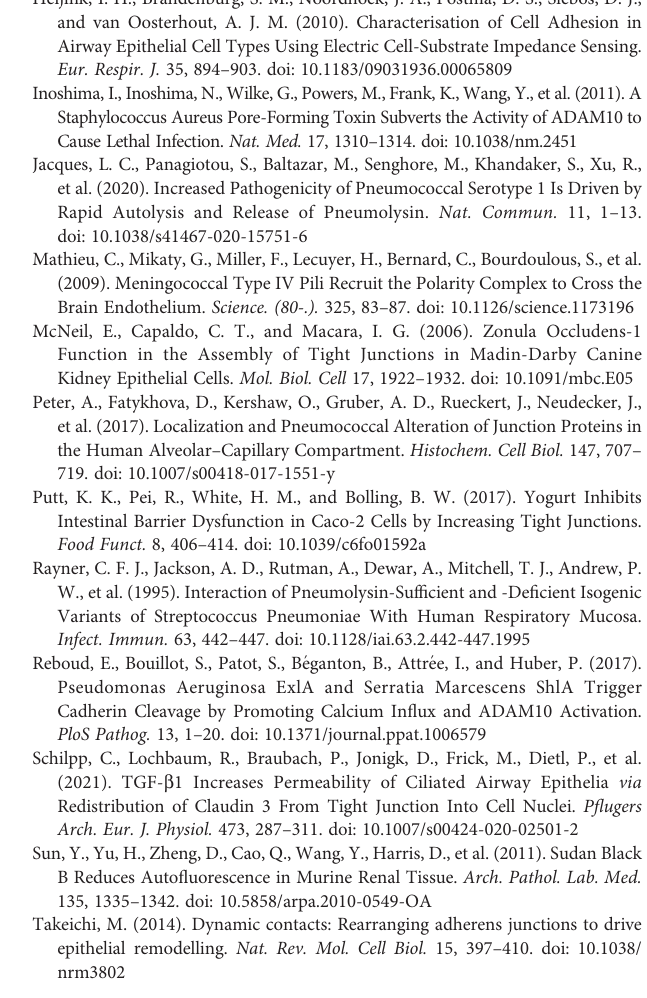
Supplementary Figure 1 | B. pertussis infection of the bronchial epithelium. Shown are the images of (A) untreated, (B) WT, and (C) D cyaA infections from (Hasan et al., 2018) that were used for IJOQ and TiJOR analysis. The original data and analysis can be found in from the following publication: (Hasan et al.